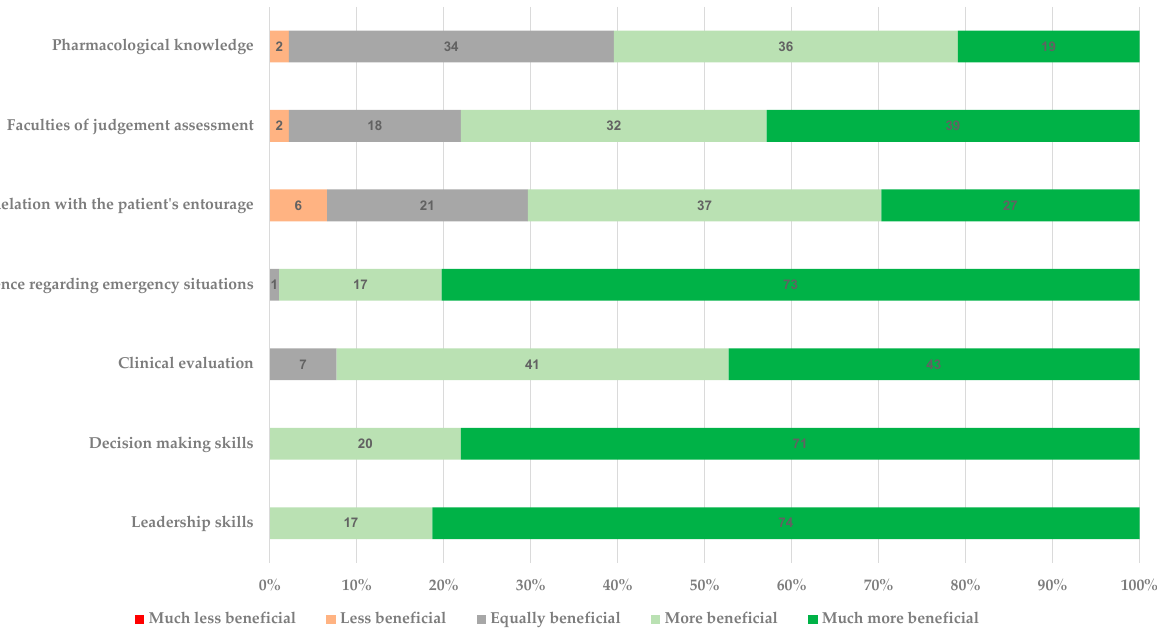
Figure 2. Added value of the prehospital rotation in comparison with other rotations.